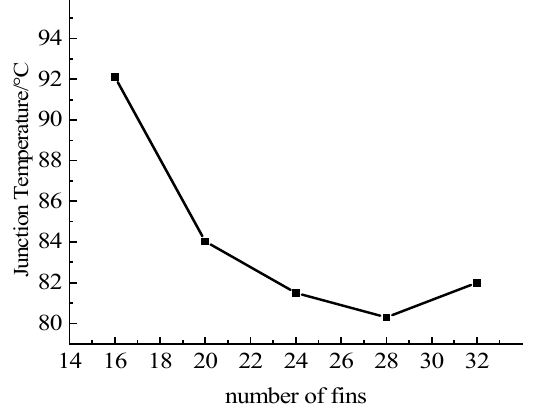
Figure 17. Relationships between the group of fins and junction